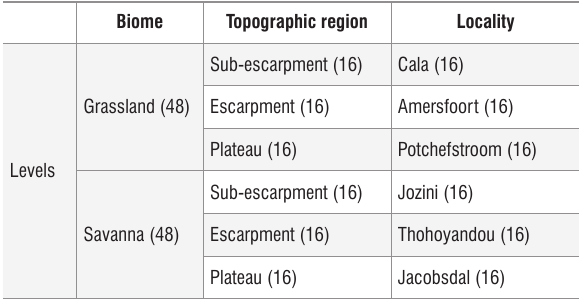
Layout of sampling design indicating the number of sample repeats ( n ) in brackets for the respective areas